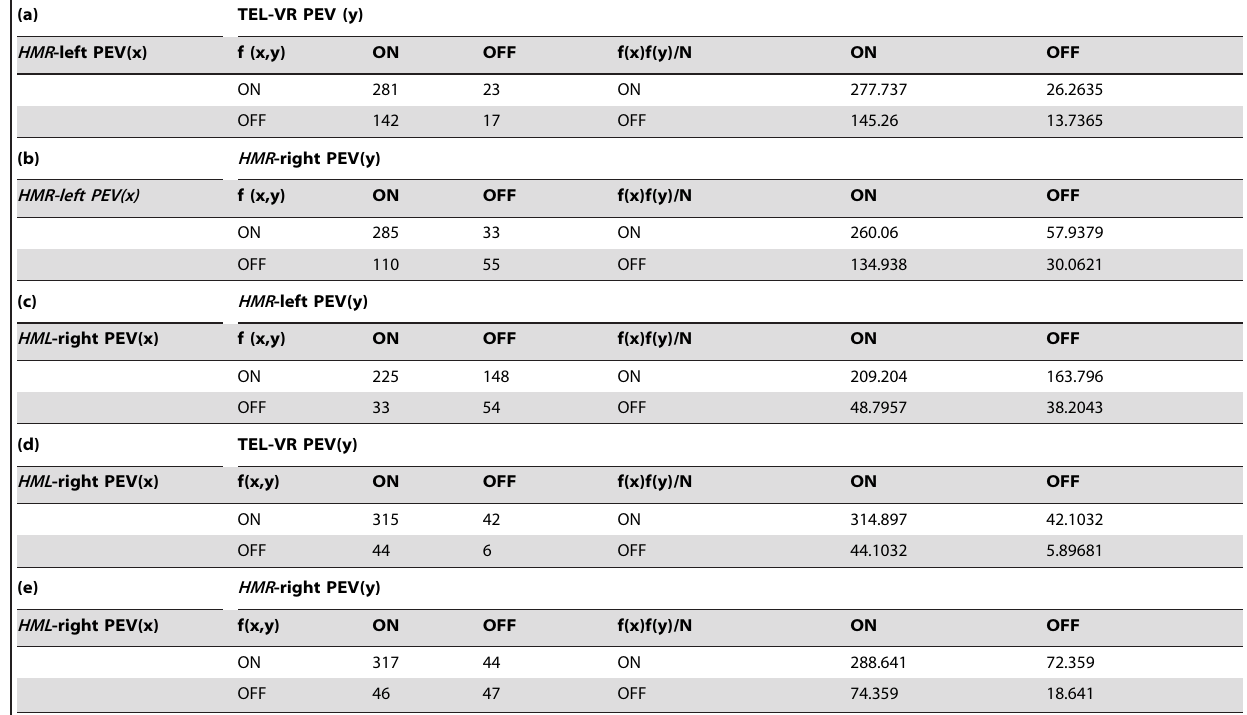
Table 6. Contingency tables of statistical test for